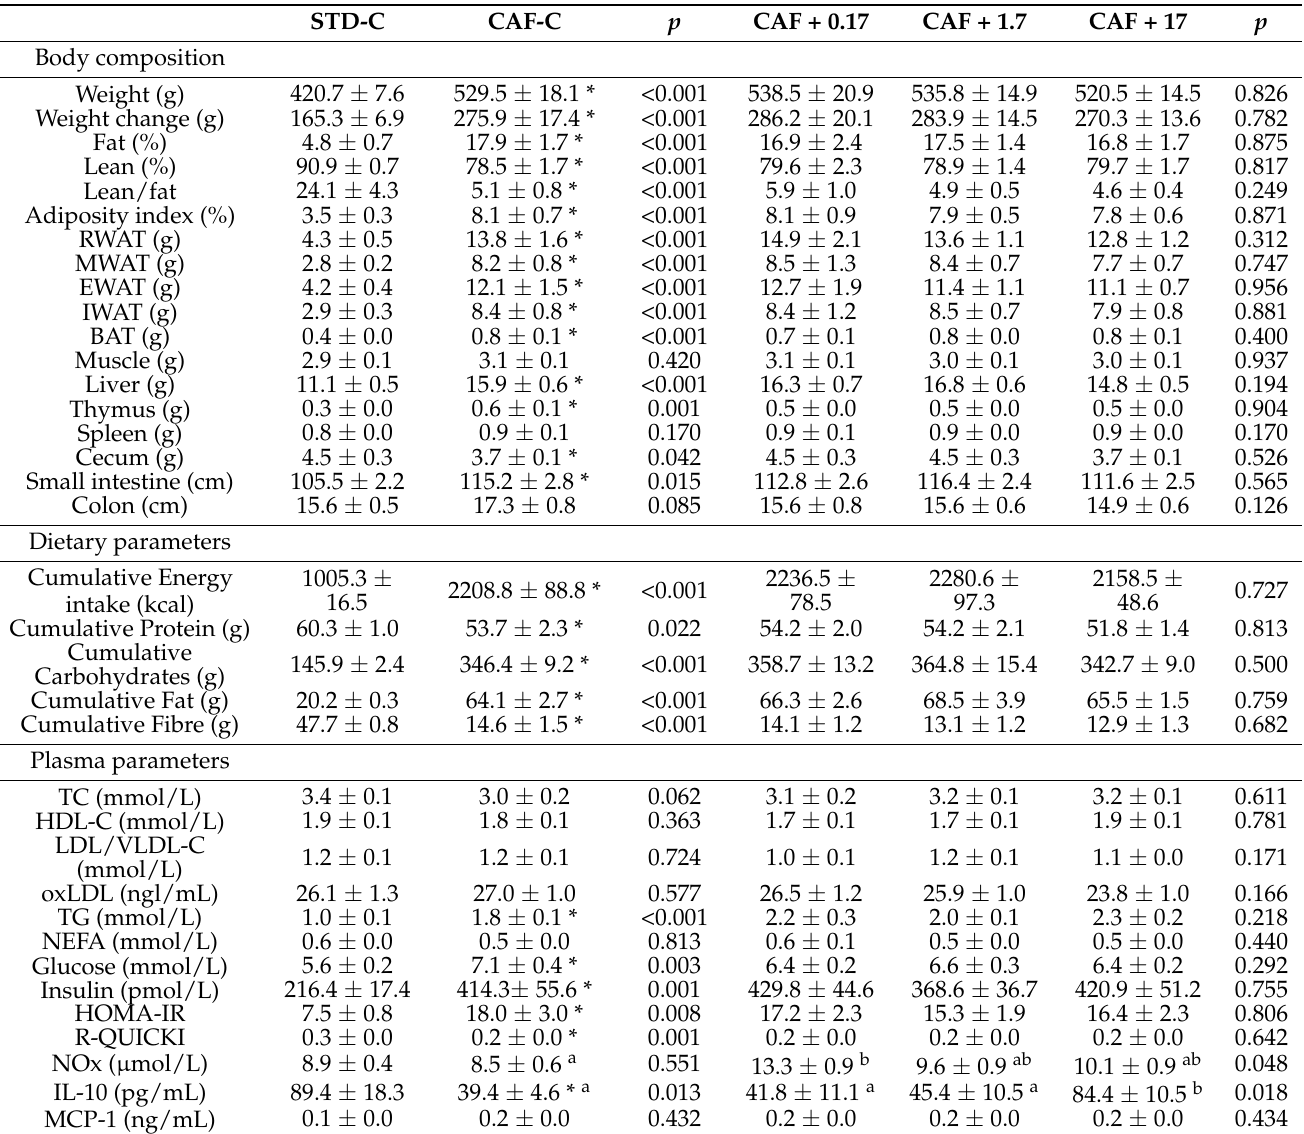
Table 4. Body composition and dietary and biochemical parameters of rats supplemented with vehicle (C) or TetraSOD ® at the 16th week of the study in the two different dietary models (STD or